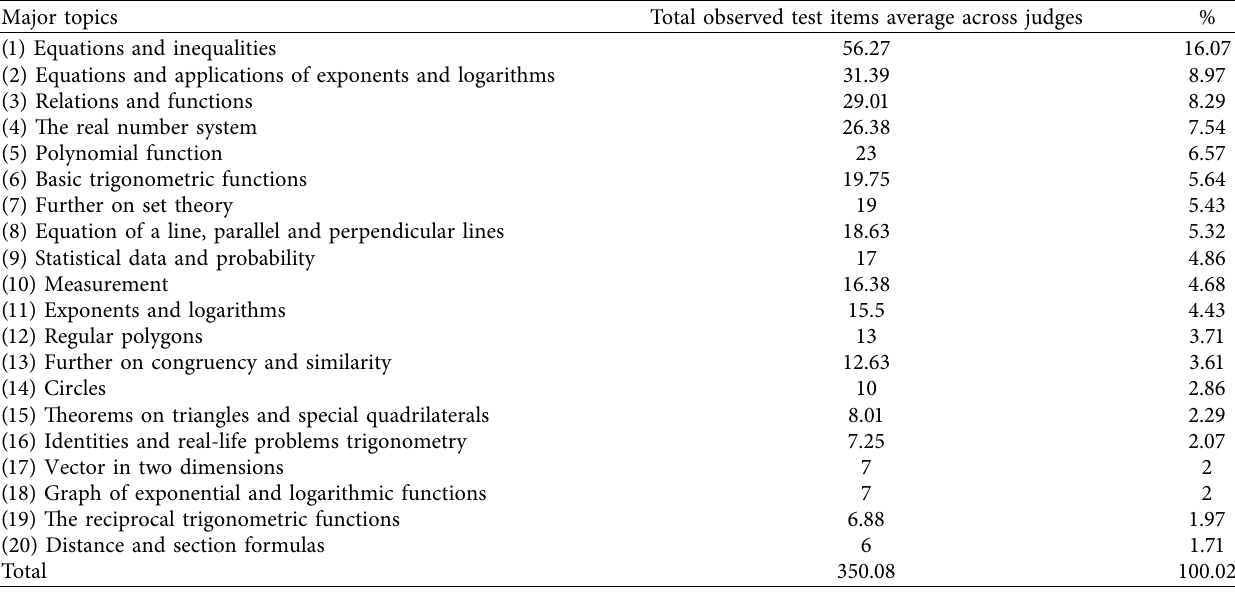
Table 6: The categorization of tests items into the syllabus contents average across